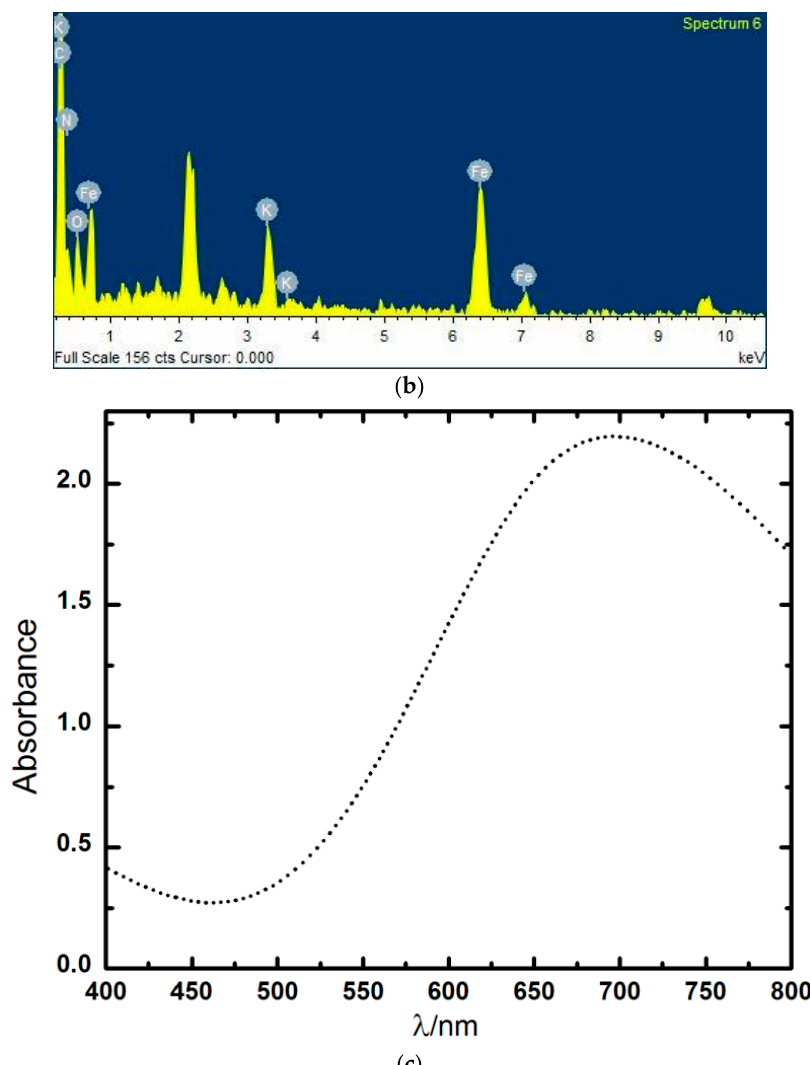
Figure 3. ( a ) SEM image of PB nanoparticles. ( b ) EDX of PB nanoparticles. ( c ) UV-VIS spectra of PB nanoparticles.